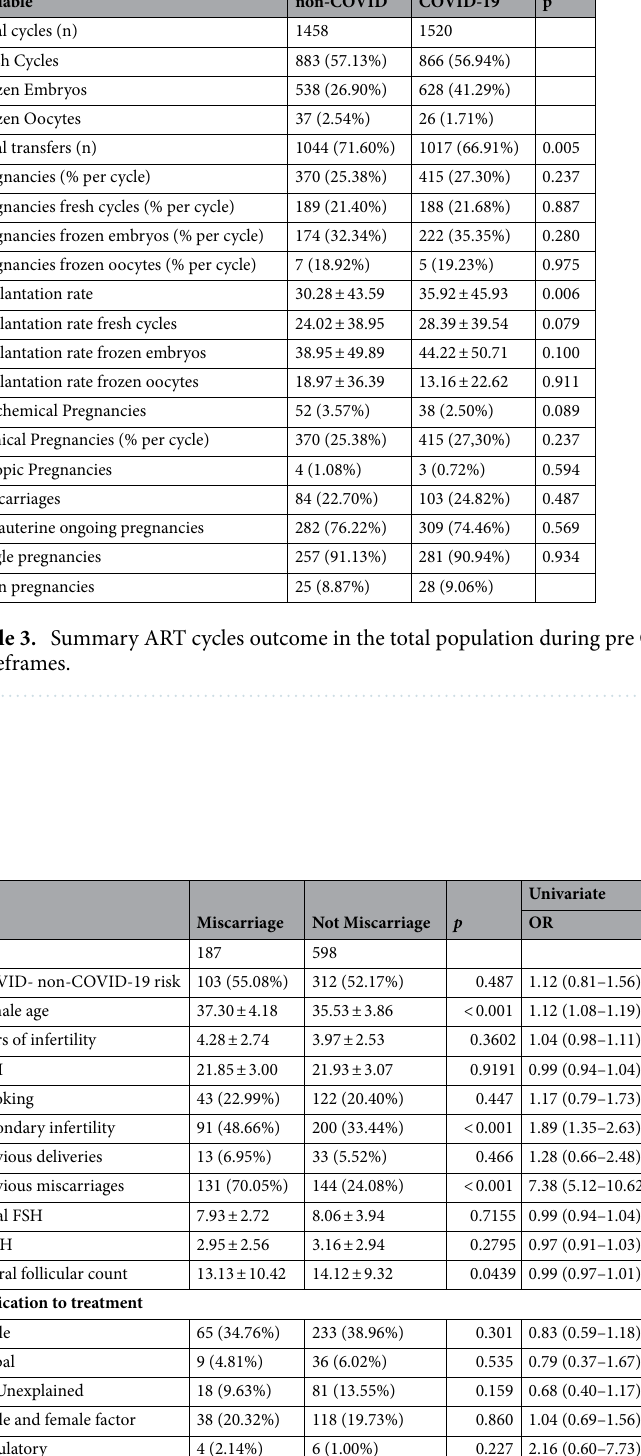
Table 4. Univariate and multivariate analysis for variables potentially related to miscarriage rate in the analyzed population.